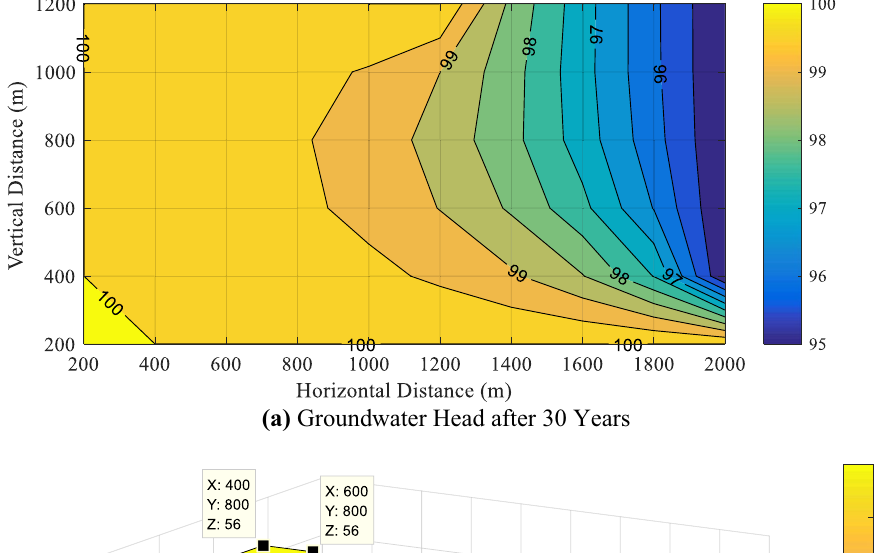
Fig. 5 Groundwater head and Chromium concentration distribution